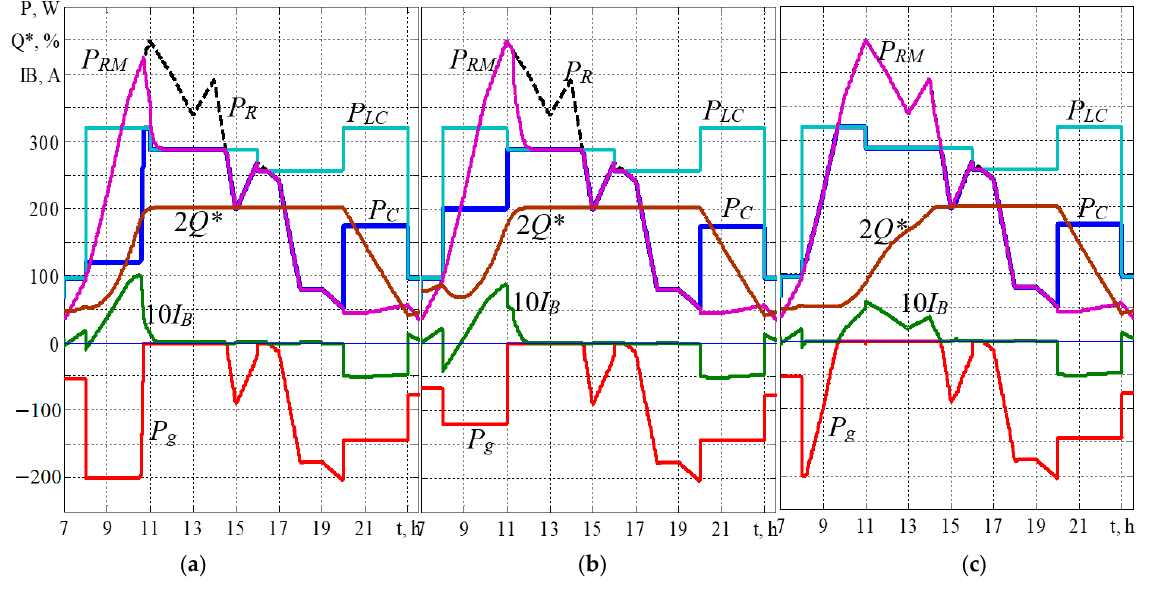
Figure 5. Oscillograms for June Day at: ( a ) P C 23 = 120 W; ( b ) P C 23 = 200 W; ( c ) P C 23 = P R 23 ( P LC , load power; P C , load added power; P R , the actual power of RES; P RM , maximum power of RES; P g , power consumed from the grid; P W , WG power; I B , battery current; Q* , battery state of charge).